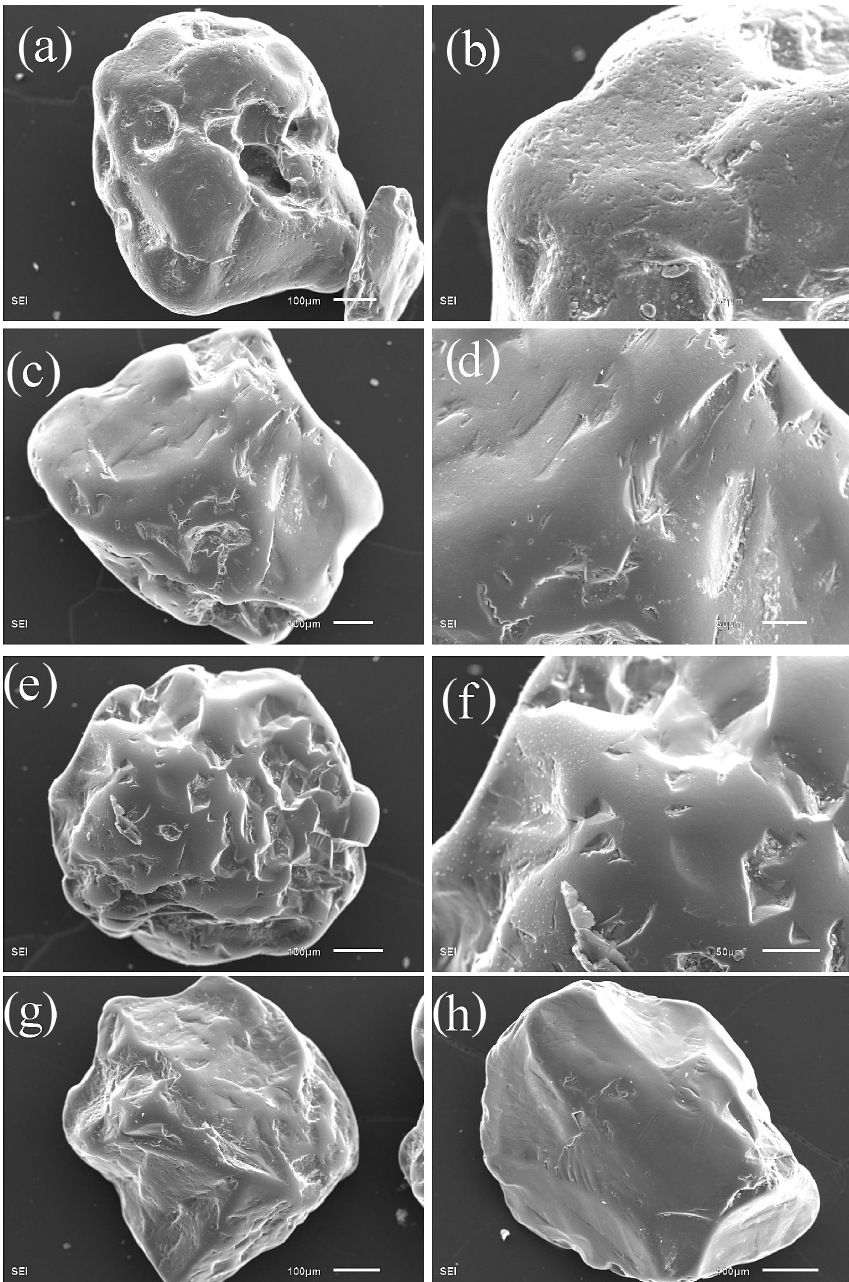
Figure A9. SEM photos of quartz grains from the section NS-20. (a, b) Matte cavernous grain with a micro-pitted surface and individual crescentic and V-shaped percussions; (c, d) glossy grain with a smooth surface, grooves and individual micro-pits; (e, f) glossy grain with deep groove and single V-shaped percussions; (g) glossy grain of irregular shape with separate V-shaped percussions and deep pits; (h) glossy grain with pre-sedimentary conchoidal fractures and